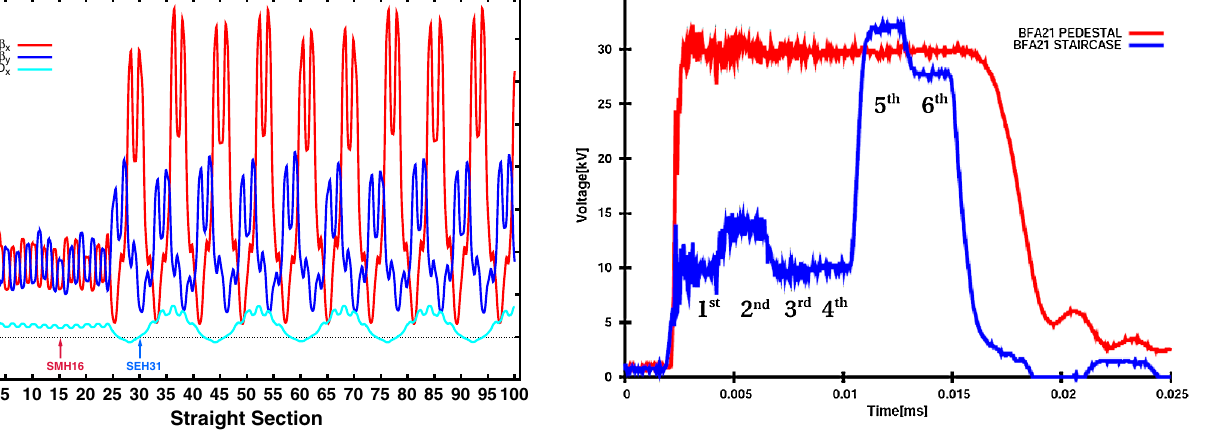
FIG. 7. BFA21 kicker strength in kV during the five extraction turns. The pulse length corresponds to six machine turns. The last part (6th) turn is used to empty the machine. During the fifth turn the remaining central part of the beam is placed above the septum to be extracted and a higher voltage is needed.